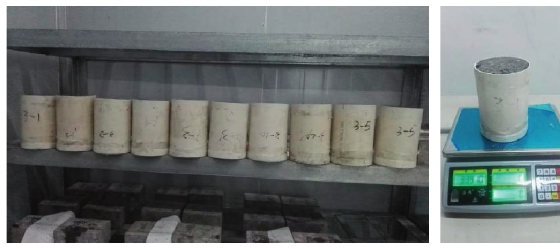
Figure 5: Water retention tests. Table 3: The strength of RAPC.